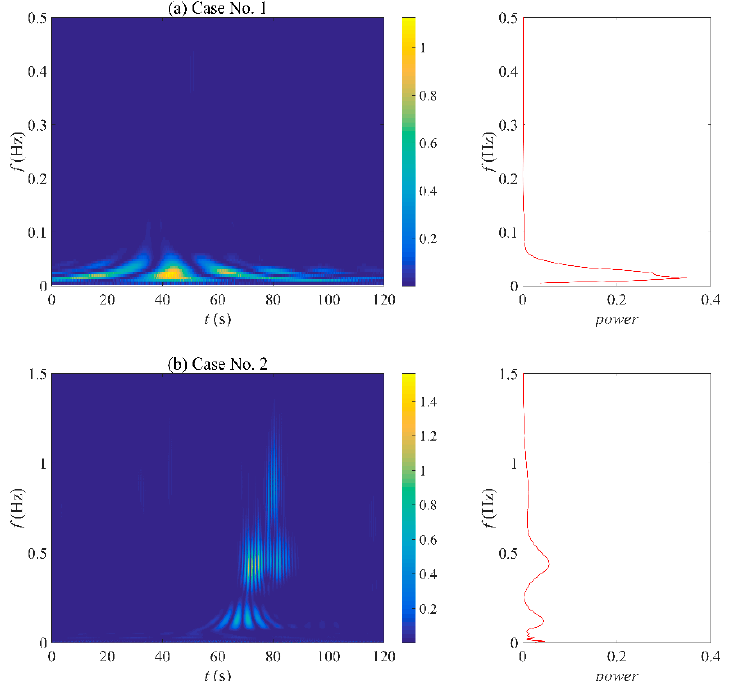
Figure 4. Wavelet power spectrum ( Left ) and global wavelet spectrum ( Right ) for the water-level time series caused by ( a ) Case No. 1 ( b ) Case No. 2.